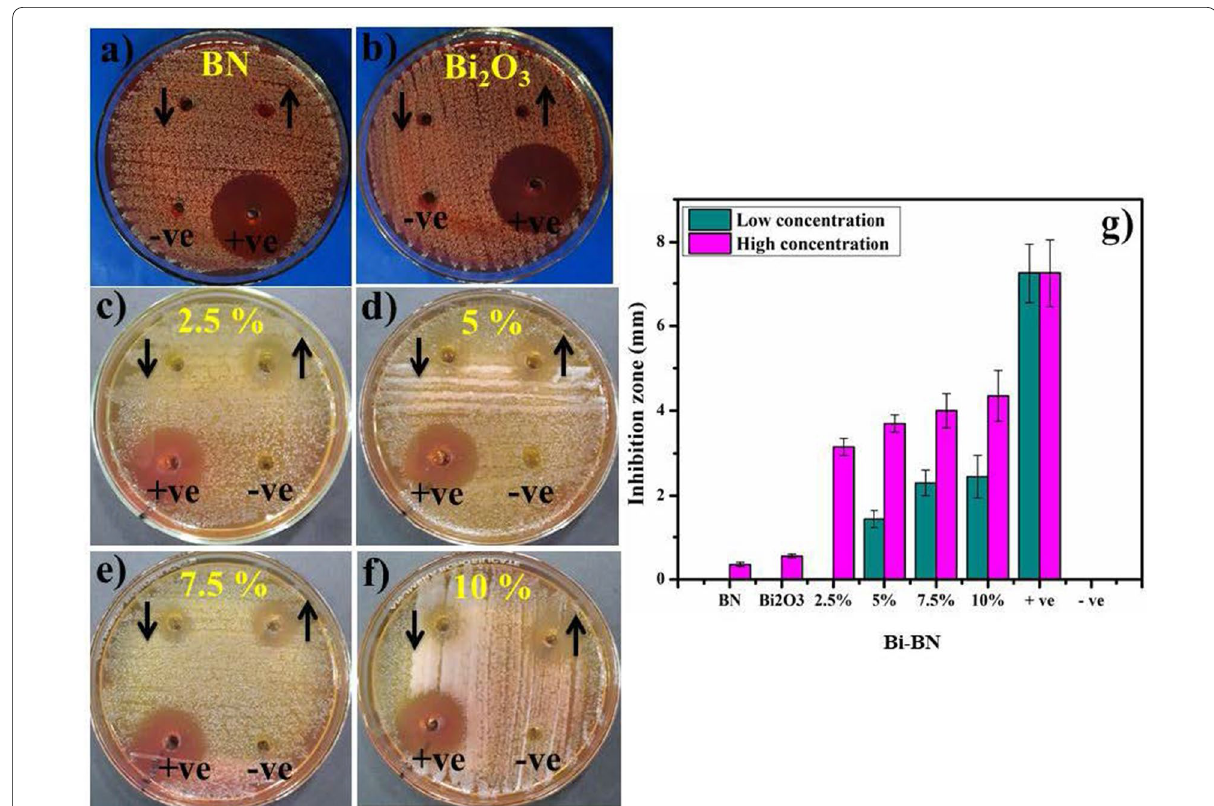
Fig. 8 a – g In‑vitro antimicrobial efficiency of BN ( a ) Bi 2 O 3 ( b ) BN nanosheets doped with various concentrations (2.5, 5, 7.5 and 10 wt%) of Bi against S. aureus ( c – f ) graphical presentation ( g